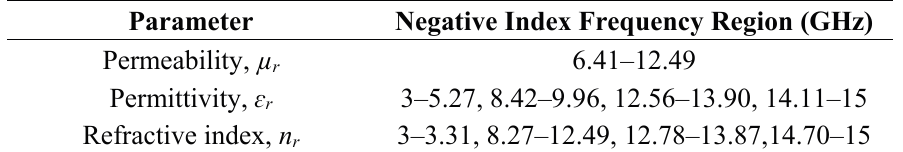
Figure 5. The observed effective parameters. ( a ) Permeability; ( b ) Permittivity; ( c ) Refractive index of the proposed unit cell. Table 2. The retrieved effective parameters in the negative index frequency